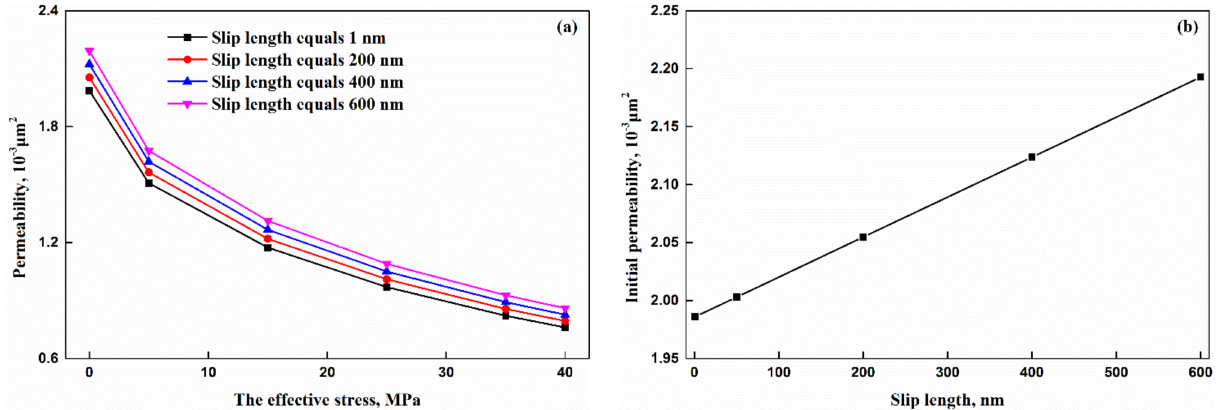
Figure 7. The effect of slip lengths on permeability: (( a ) various effective stresses; ( b ) initial permeability).